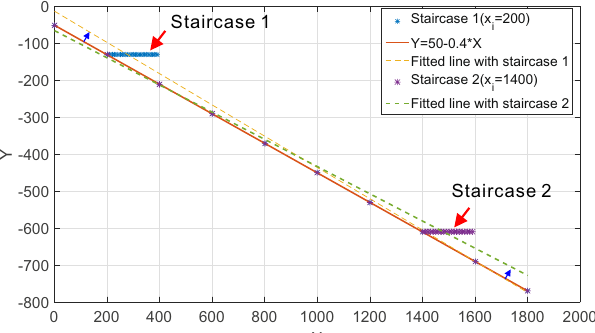
Figure 2. A case study of stairway effect. A linear relation y = 50 − 0.4 x is observed on a set of input x . Two sets of unchanging y observations are manually inserted between two actual measurement to create “stairs”. The introduction of such stairs biases the linear regression and causes estimation